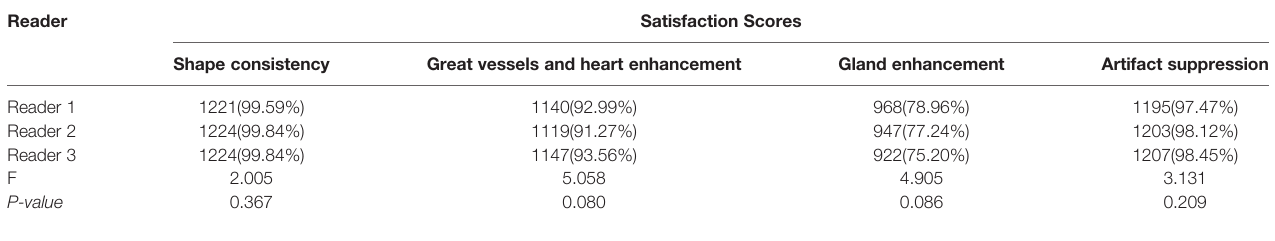
TABLE 2 | The satisfaction results of the subjective scoring of synthesized FP-Dyn images.